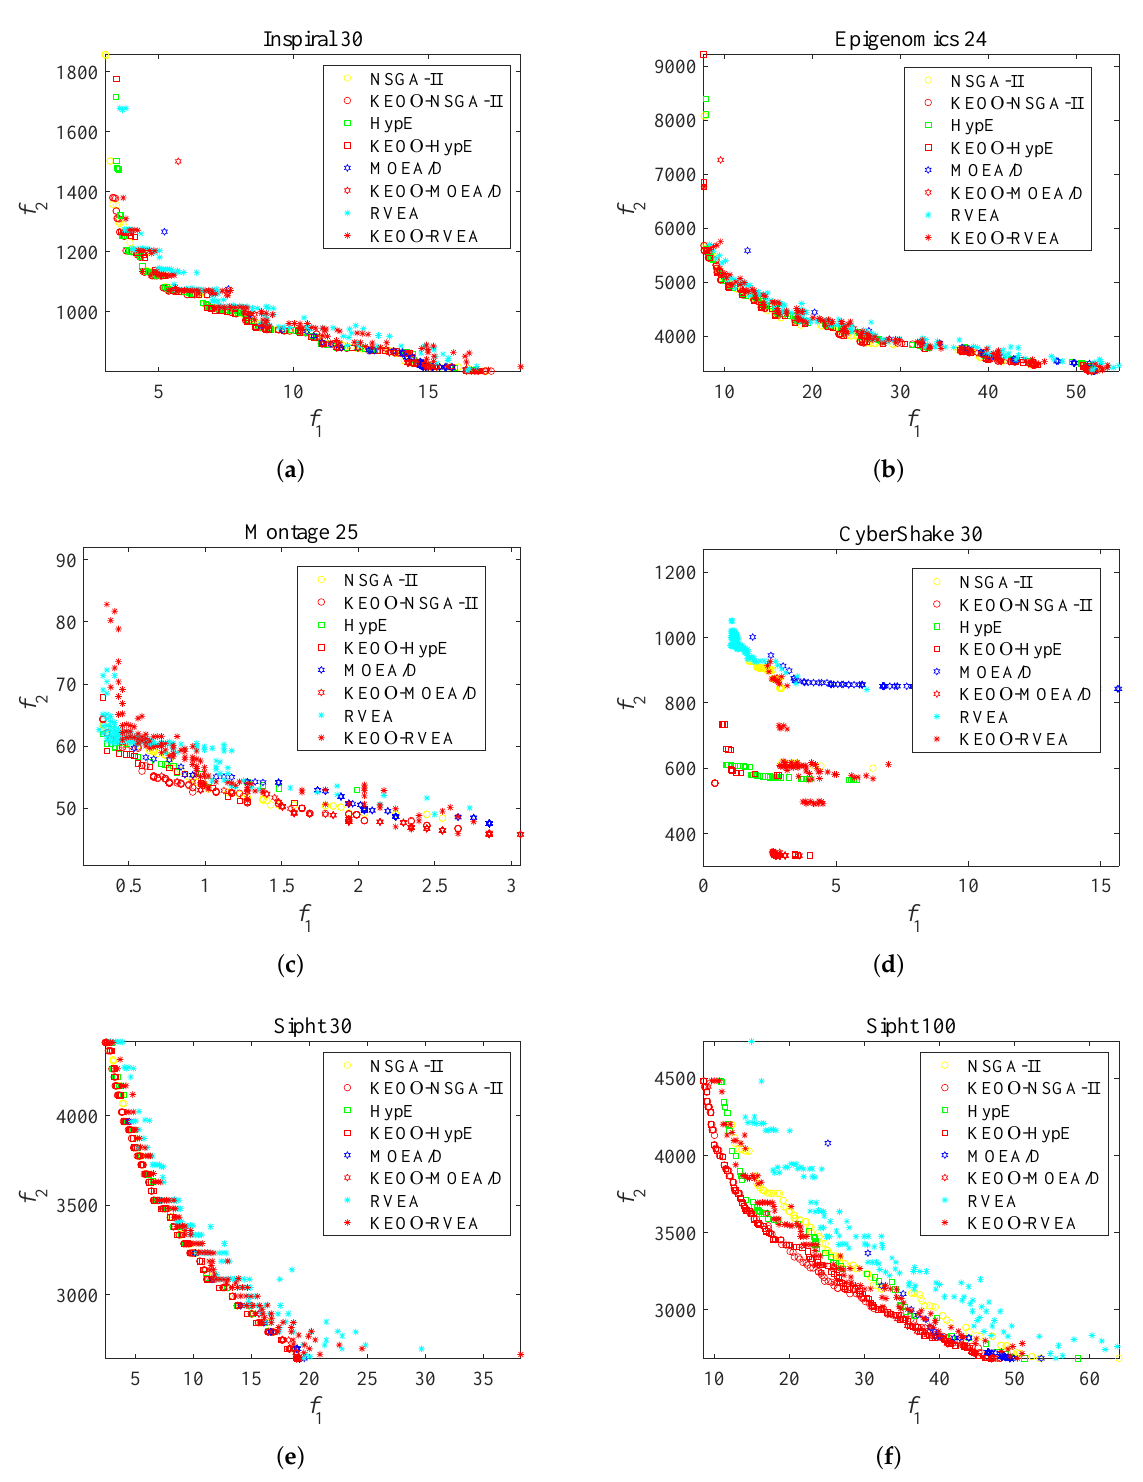
Figure 6. Distributions of populations obtained by the 8 algorithms on Inspiral, Epigenomics, Montage, CyberShake, and Sipht with around 30 tasks as well as Sipht with around 100 tasks. ( a ) on Inspiral with 30 tasks; ( b ) on Epigenomics with 24 tasks; ( c ) on Montage with 25 tasks; ( d ) on CyberShake with 30 tasks; ( e ) on Sipht with 30 tasks; ( f ) on Sipht with 100